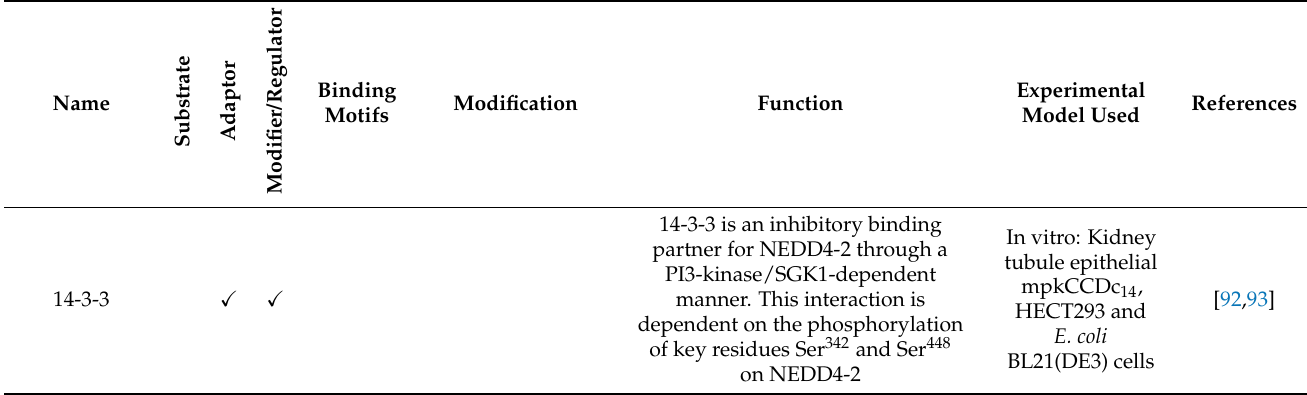
Table 2. Substrates, adaptors, and modifiers/regulators of